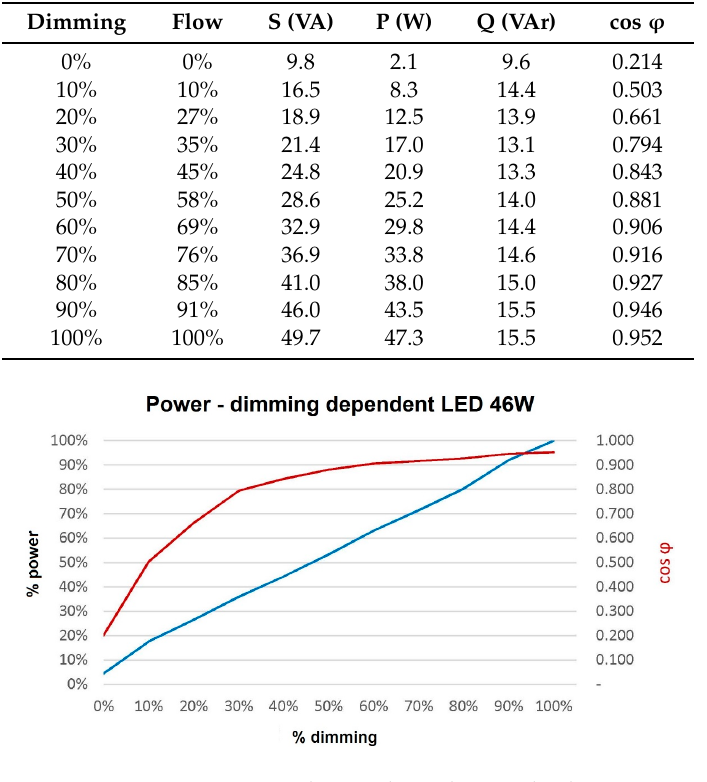
Figure 17. System used in the lab to control a 46 W LED lamp.